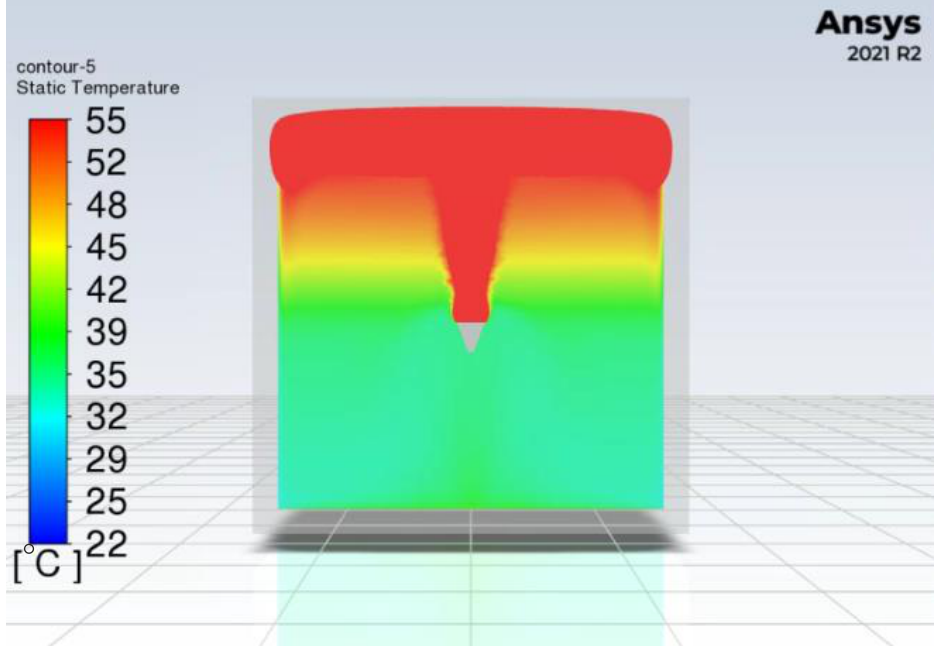
Figure 10. Temperature distribution in the plane of symmetry x = 0.375 m, °C (marked surface — isotherm of 55 °C).